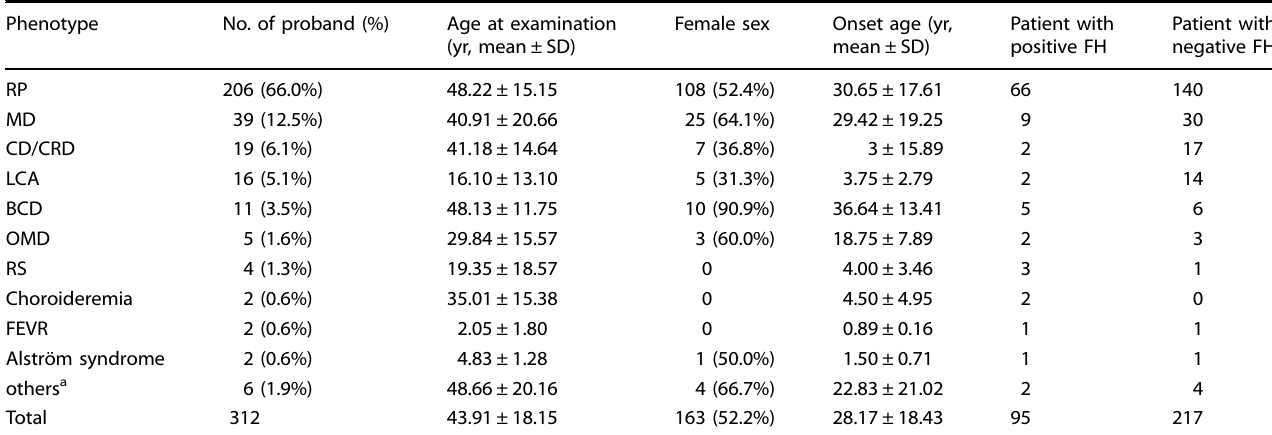
Table 1. Demographic Data of TIP